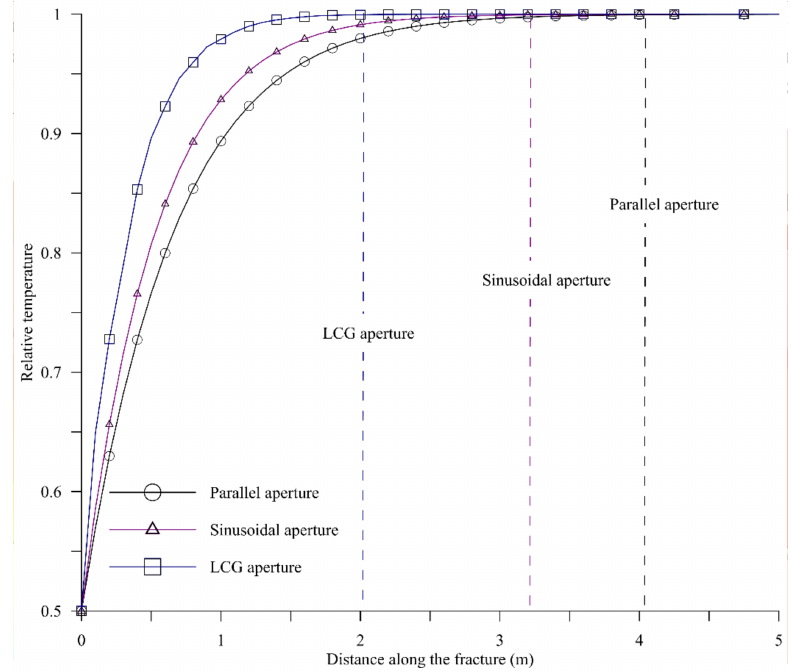
Figure 3. Propagation of thermal fronts in the fracture for different types of fracture at 100